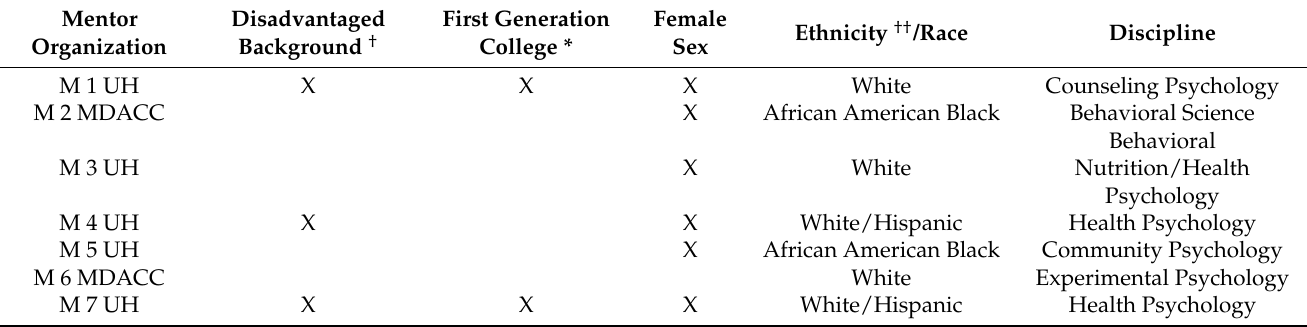
Table 2. Descriptive characteristics of the UHAND mentors ‡ —Cohorts 1 and